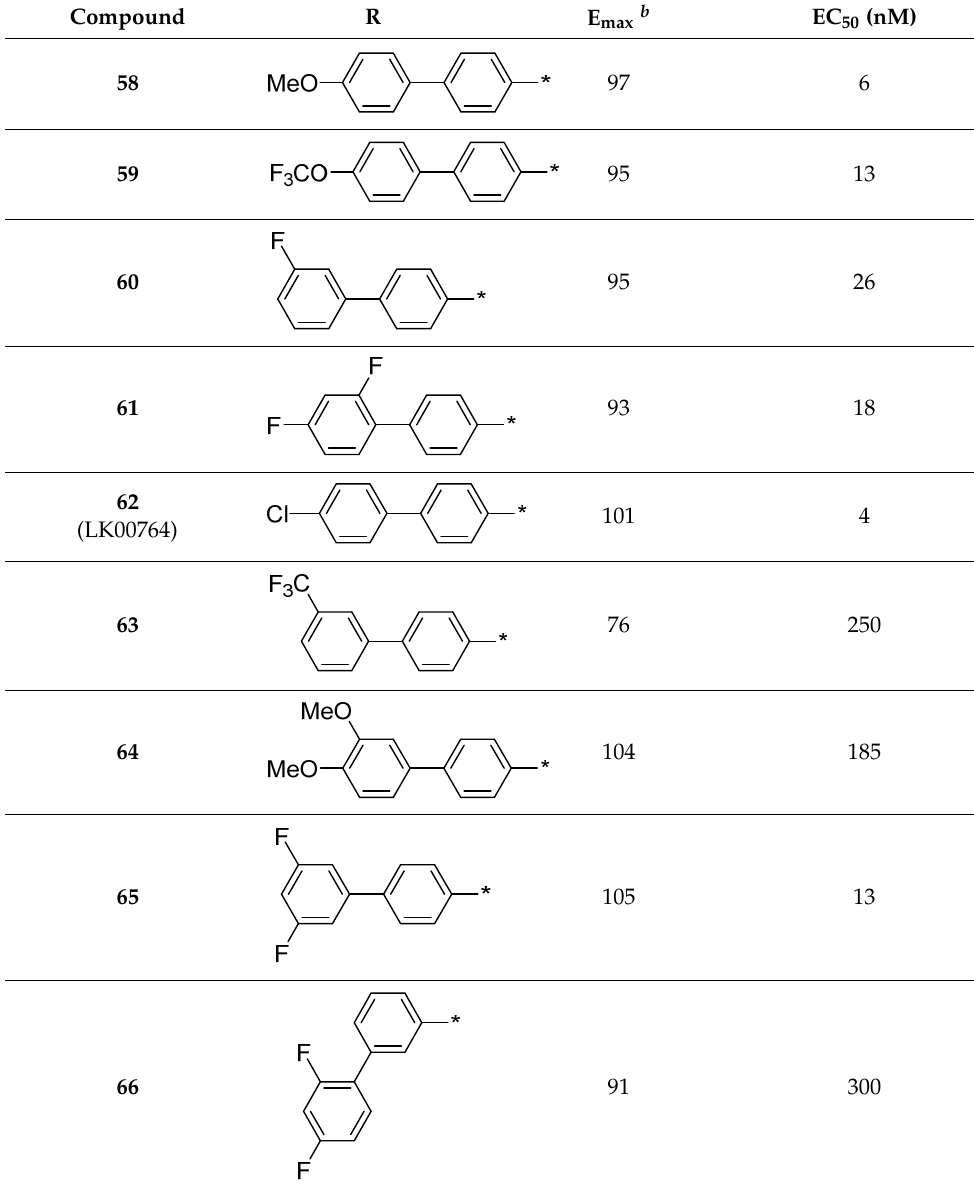
Table 2. Agonistic activity of biphenyl analogs 58 – 67 of screening hit compounds 1 – 2 with respect to TAAR1 receptor a .